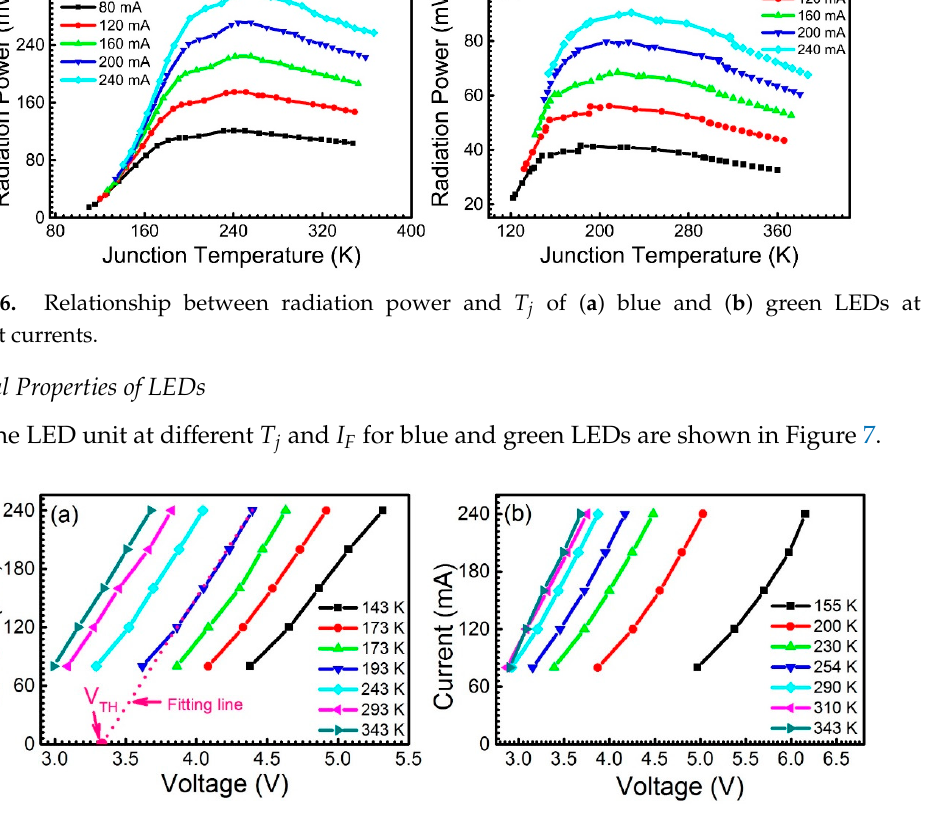
Figure 7. Forward current vs. forward voltage at different T j for blue LED ( a ) and green LED ( b ). The linear fitting (dotted line) at T j = 193 K for blue LED is shown in Figure 7a. The intercept of the fitting line at the x -axis is V TH .